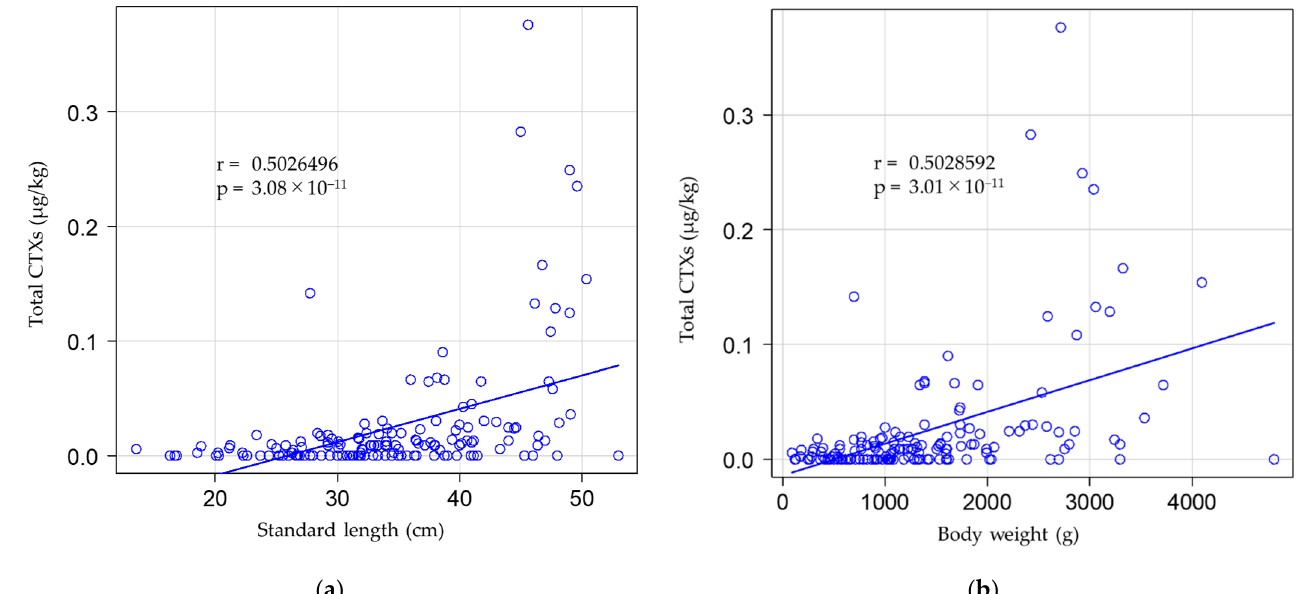
Figure 6. The relationship between fish size (( a ): SL, ( b ): BW) and total CTX levels in the flesh of V. louti specimens collected from Ryukyu Island, Japan.